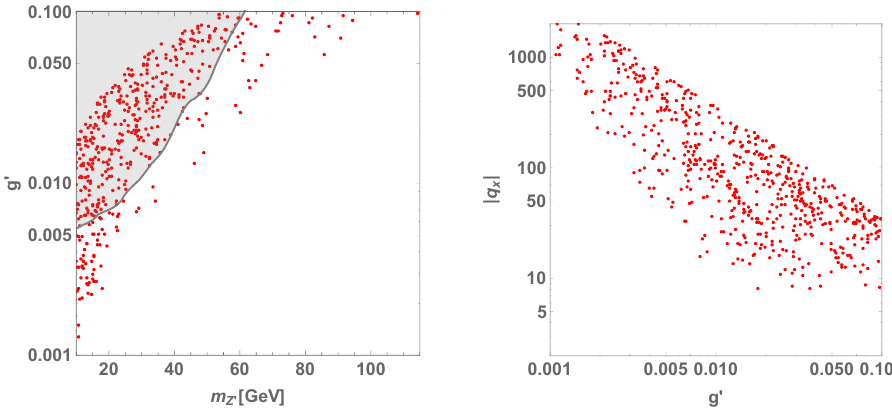
Figure 6 . Left: parameter points on ( m Z 0 , g 0 ) plane satisfying 0 . 69 ≤ − ∆ C µµ ∆ C 10 ≤ 0 . 56 , ∆ a new = (25 . 1 ± 5 . 9) × 10 − 10 and other phenomenological constraints. Shaded region µ is excluded by the LHC constraint from pp → µ + µ − Z 0 ( → µ + µ − ) process [86]. Right: the same points on ( g 0 , | q x | )